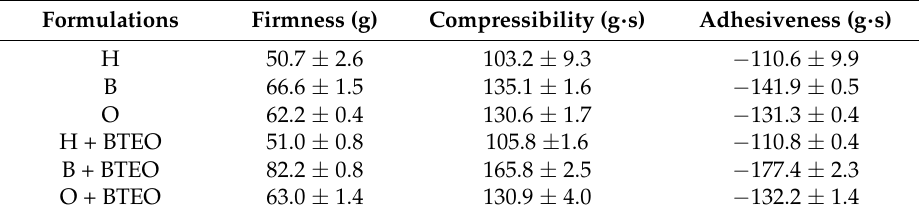
Table 2. Textural properties of the designed formulations without (H, B, O) and containing essential oil of Bidens tripartita (H + BTEO, B + BTEO, O +